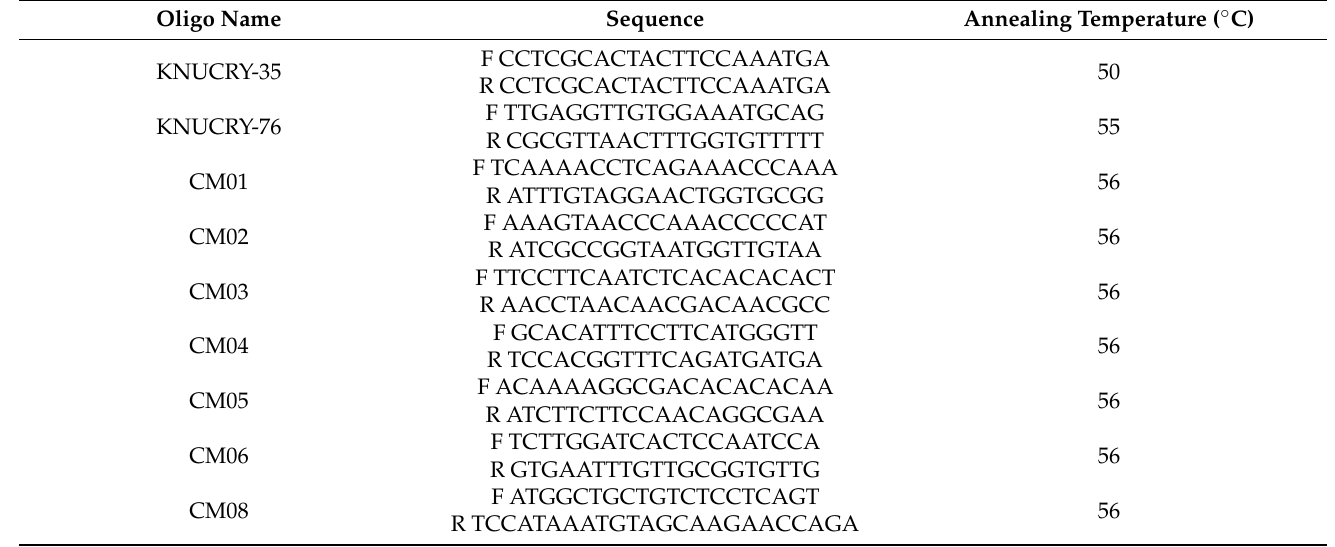
Table 1. List of SSR primers used in the study